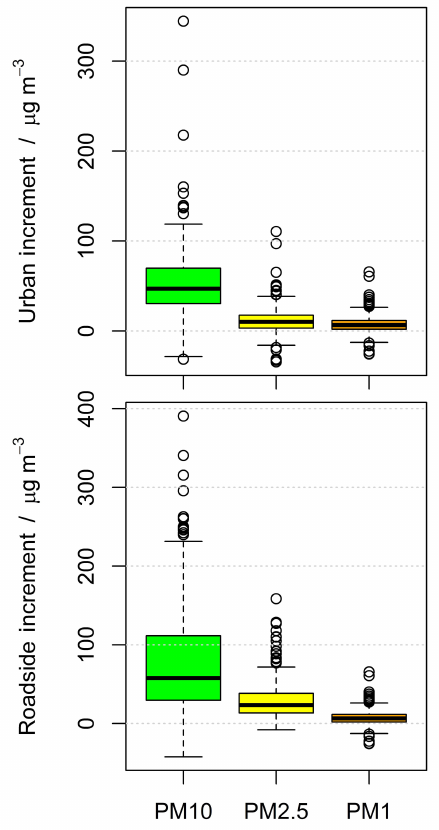
Figure 5. Box and whisker plots of urban and roadside increment of PM 10 , PM 2 . 5 and PM 1 calculated for Nairobi. Data were taken from the intensive campaign period when the urban background, urban roadside and rural background sites were all measuring si- multaneously. Hourly averaged mass concentration data are